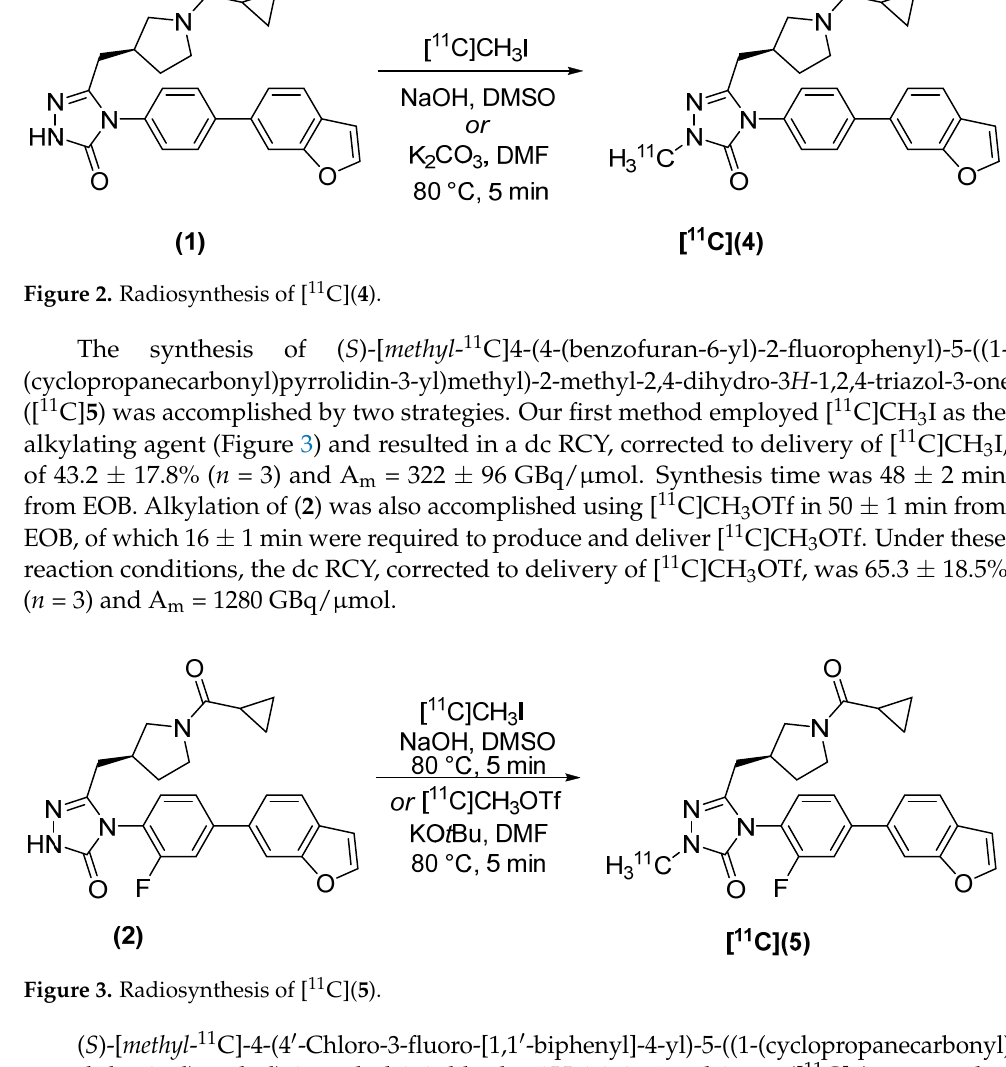
Figure 2. Radiosynthesis of [ 11 C]( 4 ).